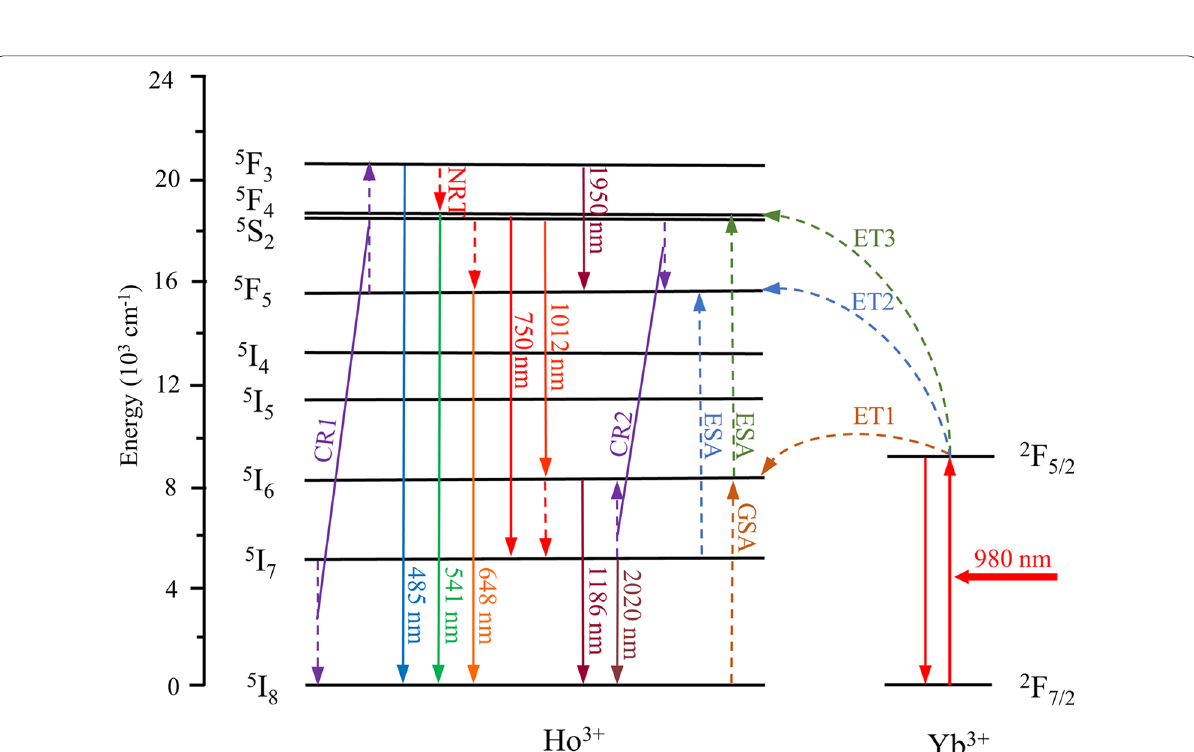
Fig. 2 The visible UCL and NIR DCL spectra of SrF 2 :Yb 3 + /Ho 3 + (12/x mol%) NCs doped with different Ho 3 + concentrations under the excitation of 980 nm CW laser